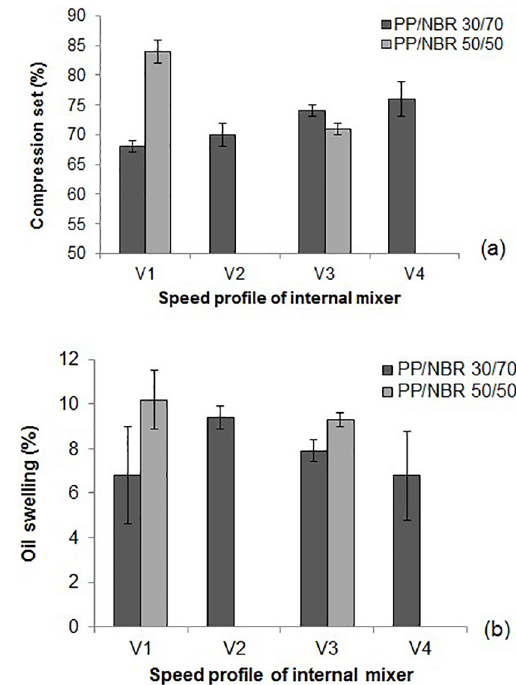
Figure 6. Compression set (a) and oil resistance (b) of the TPVs as a function of the rotor speed of internal mixer: PP/NBR 30/70 (grey) and PP/NBR 50/50 (light grey). V1= 60/60/60 rpm; V2=60/40/40 rpm; V3=60/40/60 rpm; V4=60/80/60 rpm.